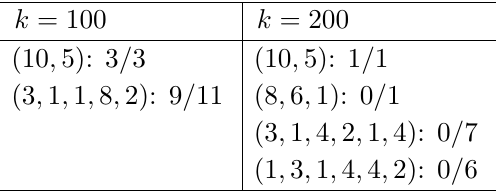
Table 8 . Kaq ness for L 26 on su (4) .